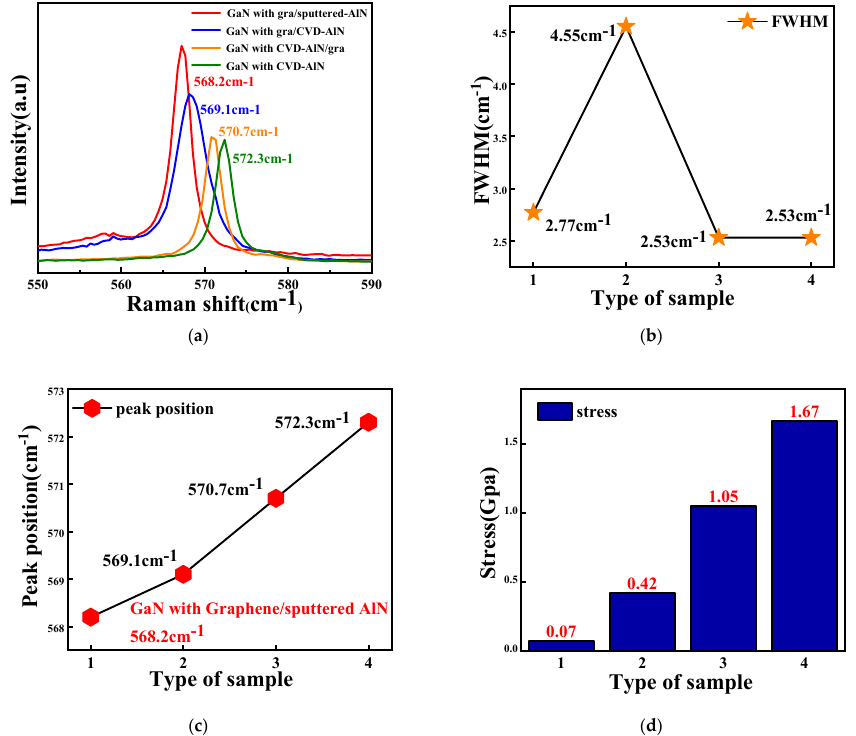
Figure 4. ( a ) E 2 (high) phonon of Raman spectra of GaN films grown on sapphire substrate with graphene/sputtered AlN buffer layer (sample 1), graphene/MOCVD AlN buffer layer (sample 2), MOCVD AlN/graphene buffer layer (sample 3), and MOCVD AlN buffer layer (sample 4) in the low ‐ wave region of 550 – 590cm − 1 ; ( b ) full ‐ widths at half ‐ maximum (FWHM) and ( c ) peak position of E 2 (high) peak of Raman spectra of the GaN films in the four different samples; ( d ) the stress value of GaN films in the four different samples.